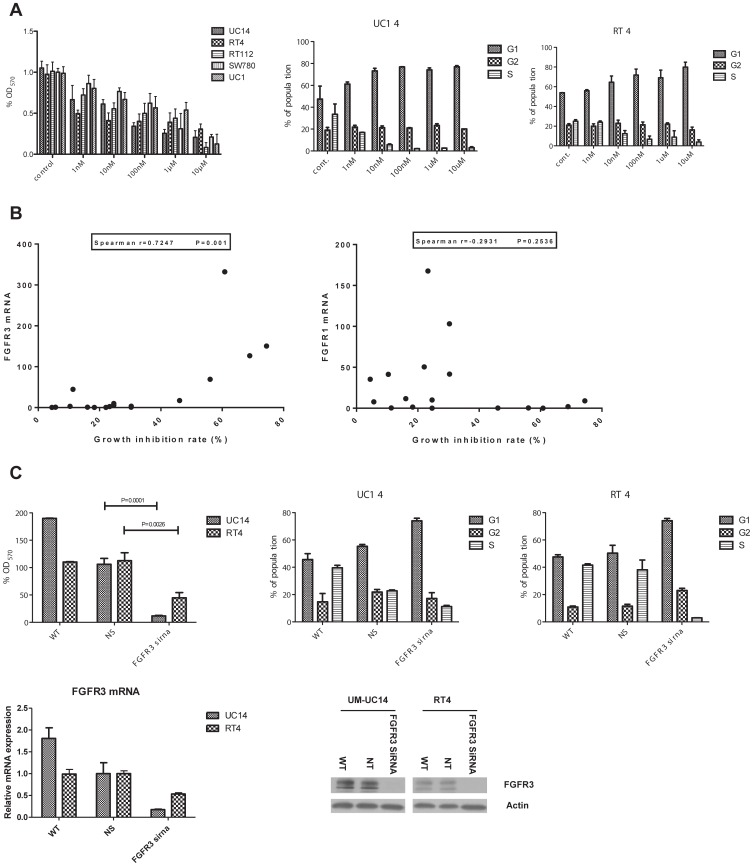
FGFR3 levels predict sensitivity to BGJ-398-induced cell cycle arrest.A. Effects of BGJ-398 on cell proliferation in the drug-sensitive cells. In the left panel, cells were incubated for 48 h in the presence of the indicated concentrations of BGJ-398 and cell growth was measured by MTT reduction. Mean ± SEM, n = 6. In the center and right panels, UM-UC14 or RT4 cells were incubated with the indicated concentrations of BGJ-398 and the percentages of cells within each cell cycle quadrant were quantified by propidium iodide staining and FACS analysis. Mean ± SEM, n = 3. B. Sensitivity to the anti-proliferative effects of BGJ-398 correlates with FGFR3 expression but not with the presence of activating FGFR3 mutations. The level of growth inhibition observed after 48 h exposure to 1 µM BGJ-398 (as measured in MTT assays) was correlated with the relative level of FGFR3 (left panel) or FGFR1 (right panel) mRNA expression in a panel of 17 human BC cell lines.. C. Effects of FGFR3 knockdown on cell proliferation. Left panel: UM-UC14 or RT4 cells were transiently transfected with either non-targeting (NT) or FGFR3-specific siRNAs and cell growth was measured at 48 h by MTT reduction. Mean ± SEM, n = 6. Center and right panels: UM-UC14 or RT4 cells were transiently transfected with either non-targeting (NT) or FGFR3-specific siRNAs and percentages of cells within each phase of the cell cycle were quantified by propidium iodide staining and FACS analysis. Mean ± SEM, n = 3. Lower panel: the efficiency of FGFR3 silencing was measured by quantitative RT-PCR and immunoblotting.